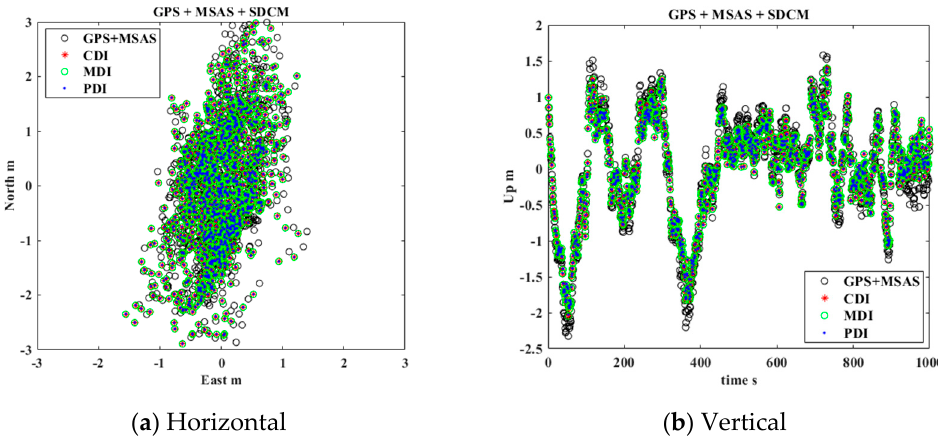
Figure 8. Estimated position errors using CDI, MDI, and PDI for single GNSS and multi-SBAS.